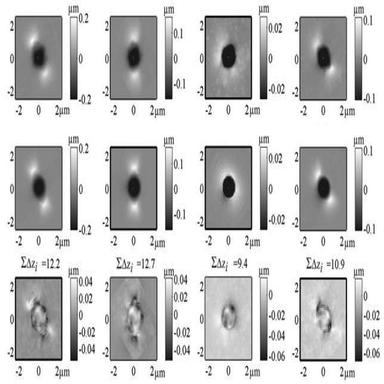
Experimental (top row) and simulated (middle row) topographies of indentations in α-Titanium. The bottom row shows the difference between these surface profiles which was used to calculate the topography contribution to the objective function. Both left columns show results used to identify Crystal Plasticity (CP) parameters while the two right columns show results used to verify these parameters. Note that the gray scale ranges of the surface upheaval are consistent only per column. Figure adopted from ](